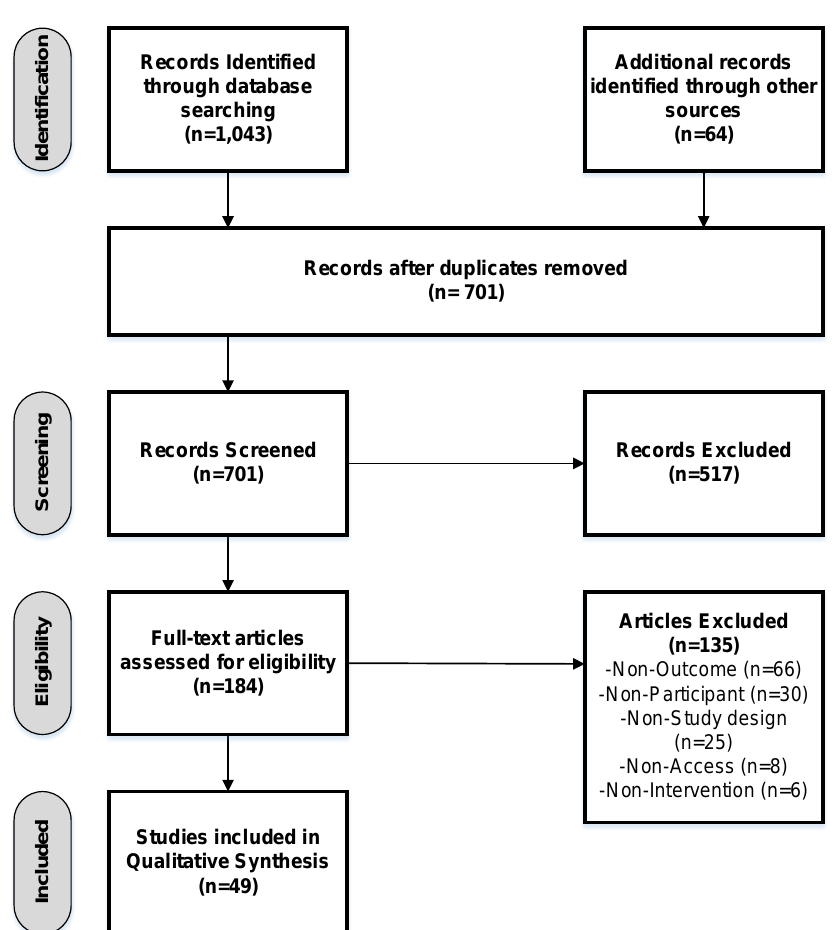
Figure 1. PRISMA flow diagram of study selection process.